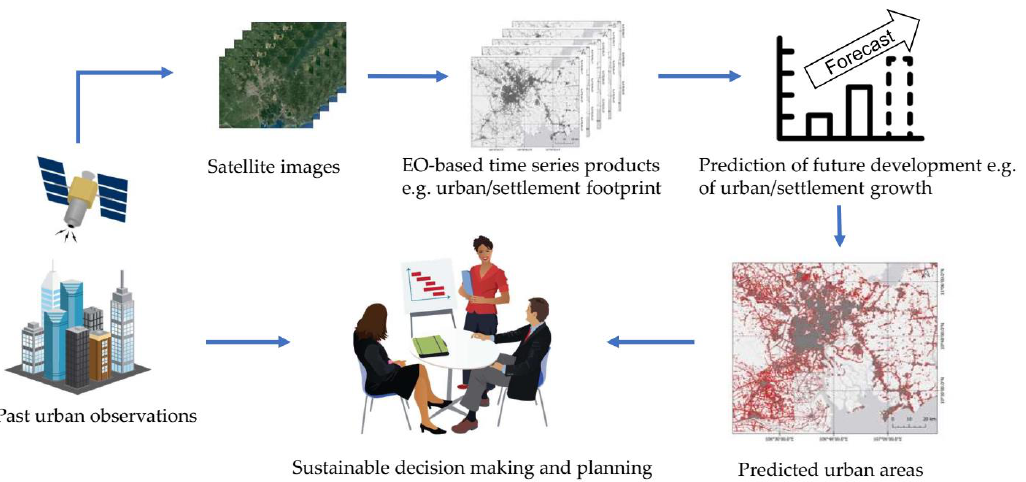
Figure 1. Prediction of future urban/settlement growth based on EO-based time series products. Source of the symbols is the Integration and Application Network (ian.umces.edu/media-library).